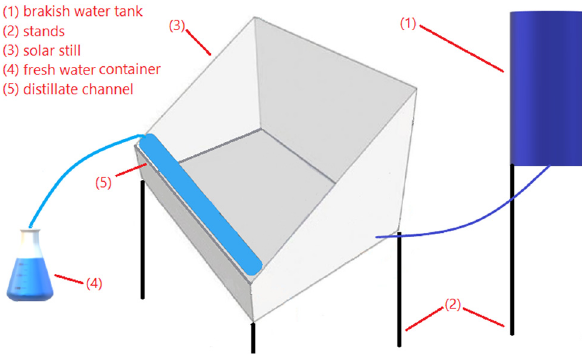
Figure 2: Line diagram of the CS system.